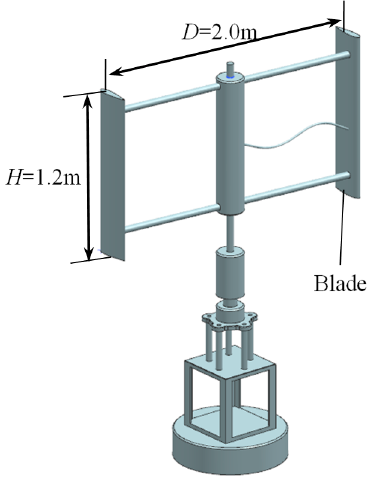
Figure 3. A Three-dimensional model of Sb-VAWT.